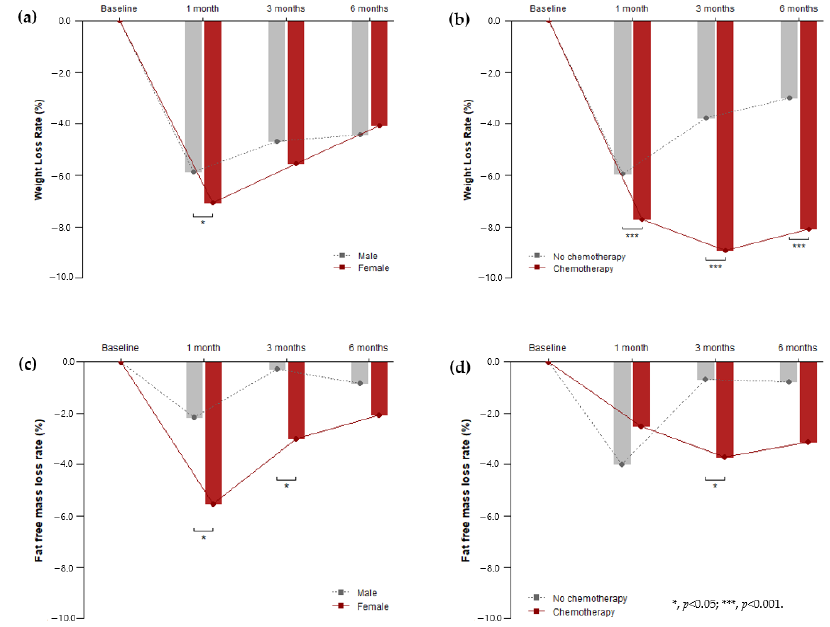
Figure 1. Change in weight/fat-free mass loss rate after gastrectomy according to gender and chemotherapy. ( a ) The difference in weight loss rates between males and females was statistically significant at one month after surgery ( p = 0.012); ( b ) chemotherapy showed a significant effect on the weight loss rate over the entire postoperative period ( p < 0.001); ( c ) the difference in the fat-free mass loss rates between males and females was statistically significant at one and three months after surgery ( p = 0.006 and 0.033, respectively); ( d ) chemotherapy showed a significant effect on the fat-free mass loss rate at three months after surgery ( p = 0.042).